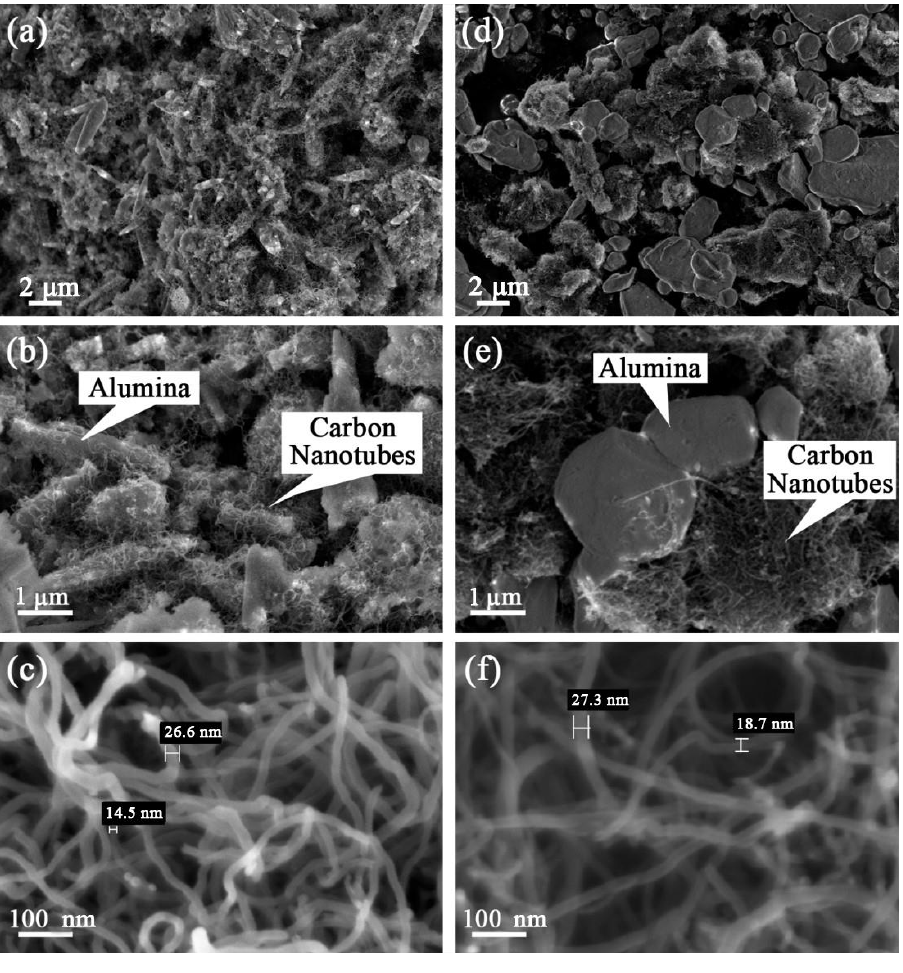
Figure 1. FESEM micrograph of the CNTs/alumina hybrid compound: ( a – c ) CVD hybrid and ( d – f ) physically hybrid.